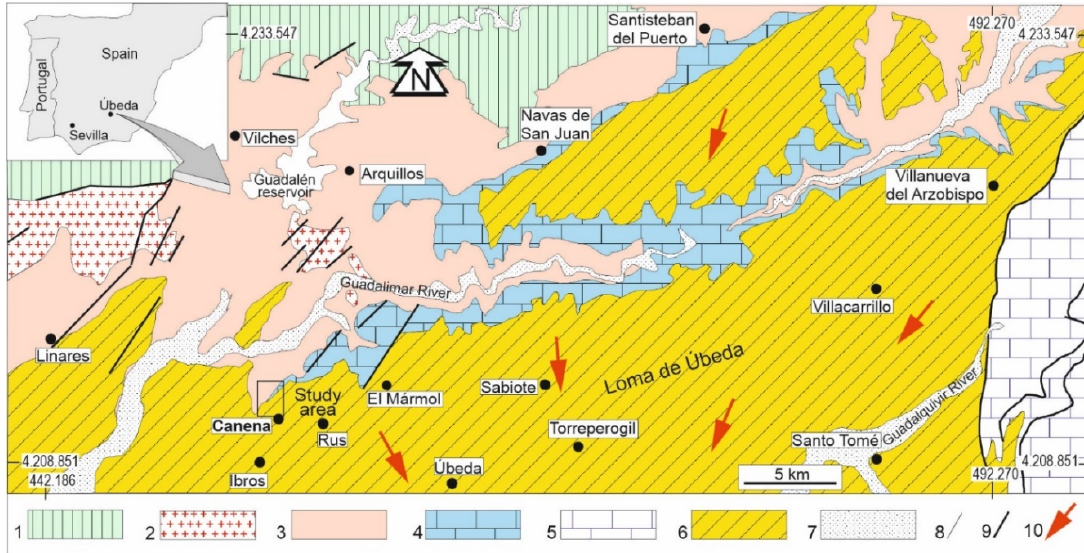
Figure 1. Regional hydrogeological map. The location of the study area is shown. Legend: (1) Paleozoic basement (Phyllites). (2) Paleozoic basement (Granite). (3) Triassic clays from Chiclana de Segura Formation (Impervious base). (4) Jurassic tabular dolomites (Aquifer). (5) Prebetic Jurassic dolomites (Aquifer). (6) Late Miocene marls with detrital levels. (7) Pliocene–Quaternary clays, marls, and conglomerates. (8) Undifferentiated stratigraphic contact. (9) Undifferentiated tectonic contact. (10) Groundwater flow paths.